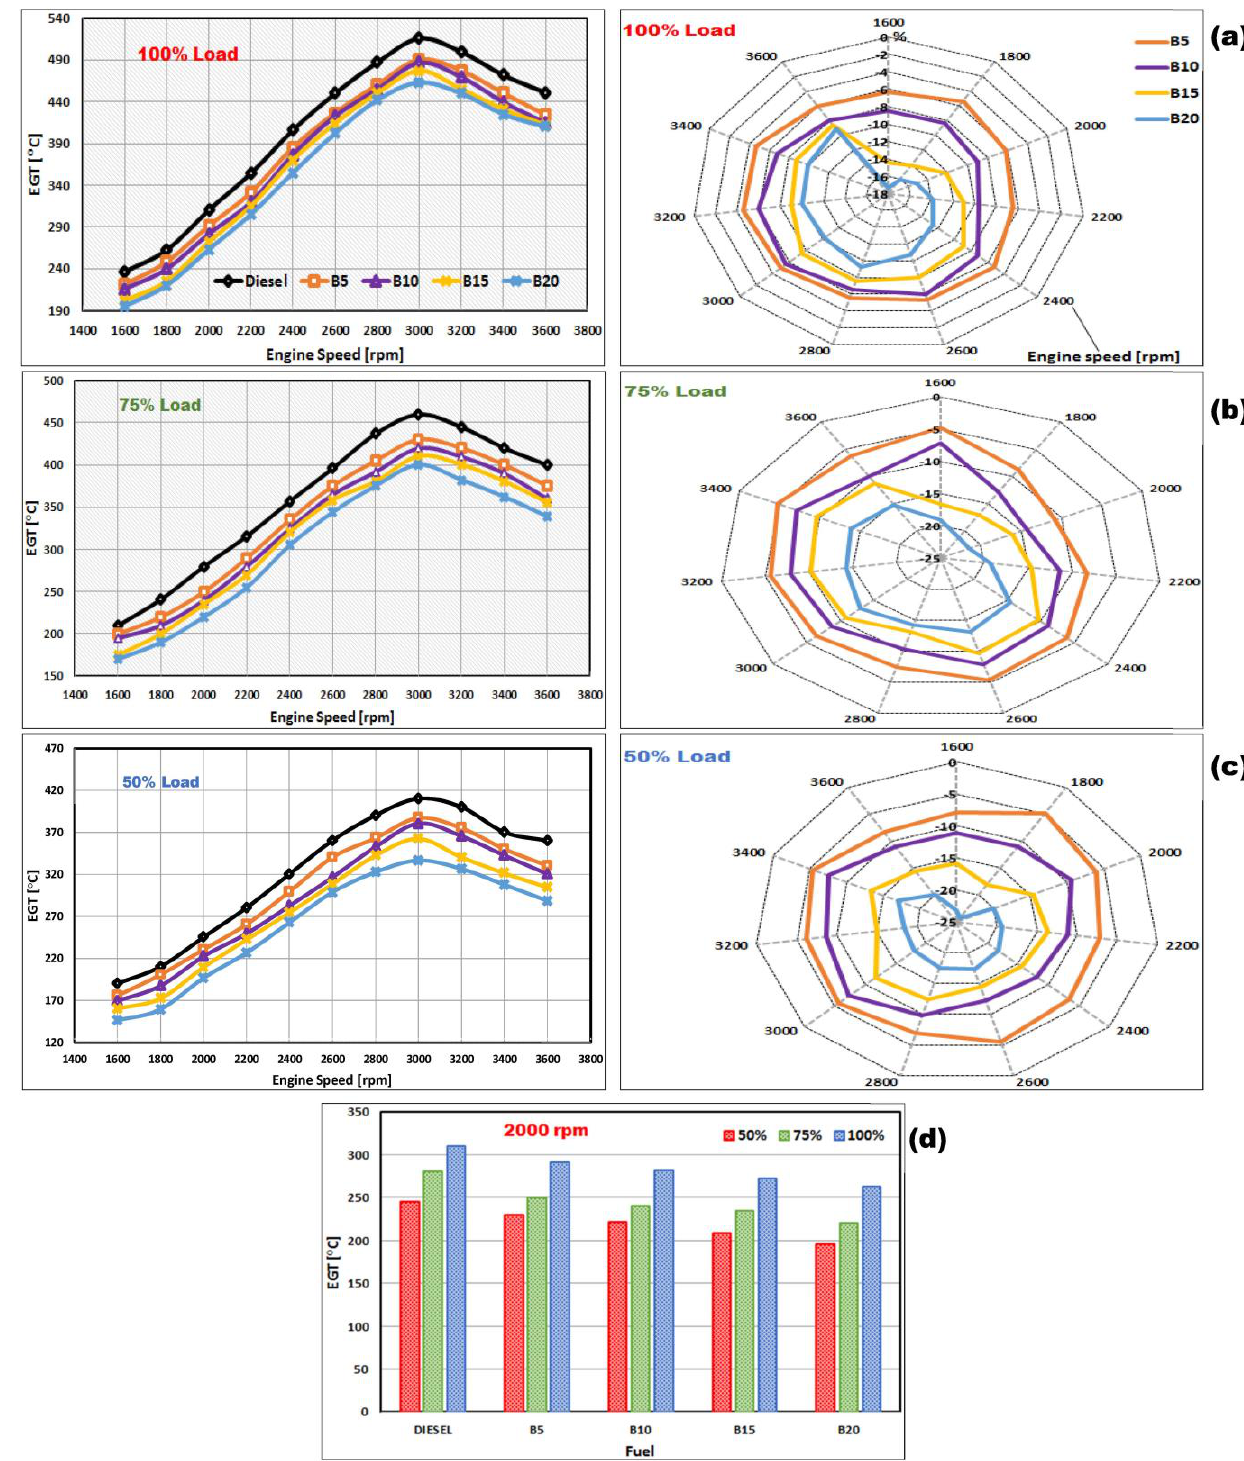
Figure 9. Exhaust gas temperature variation with engine speed, presented as trends (left) and normalized value contours (right) for (a) 100% load, (b) 75% load, and (c) 50% load; (d) compares all fuels and loads at 2000 rpm.